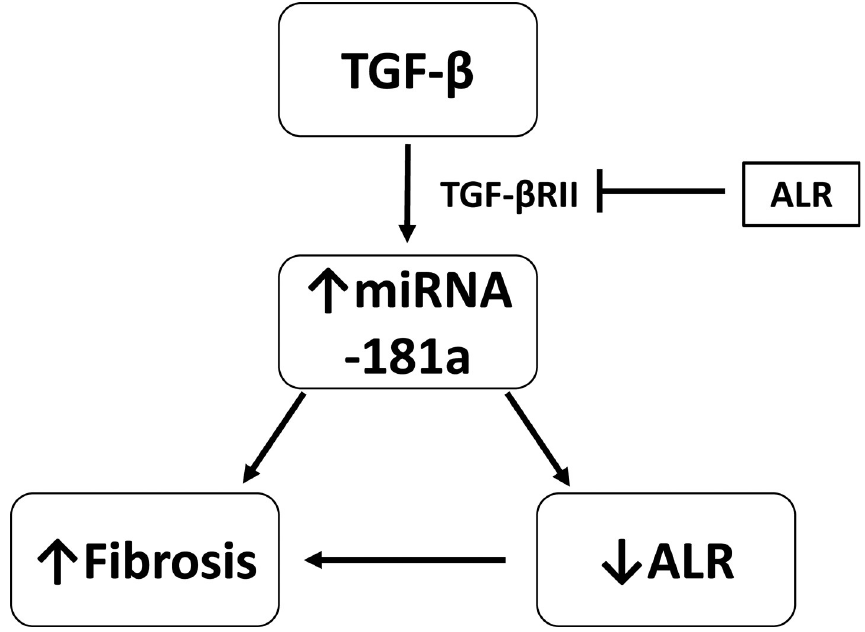
Fig 6. Proposed mechanism of TGF- β -induced miRNA-181a and fibrosis. TGF- β induces fibrosis by upregulating miRNA-181a expression, which in turn inhibits ALR expression and fibrosis. Overexpression of ALR inhibited TGF- β - induced firbrogenic changes by inhibiting TGF- β RII